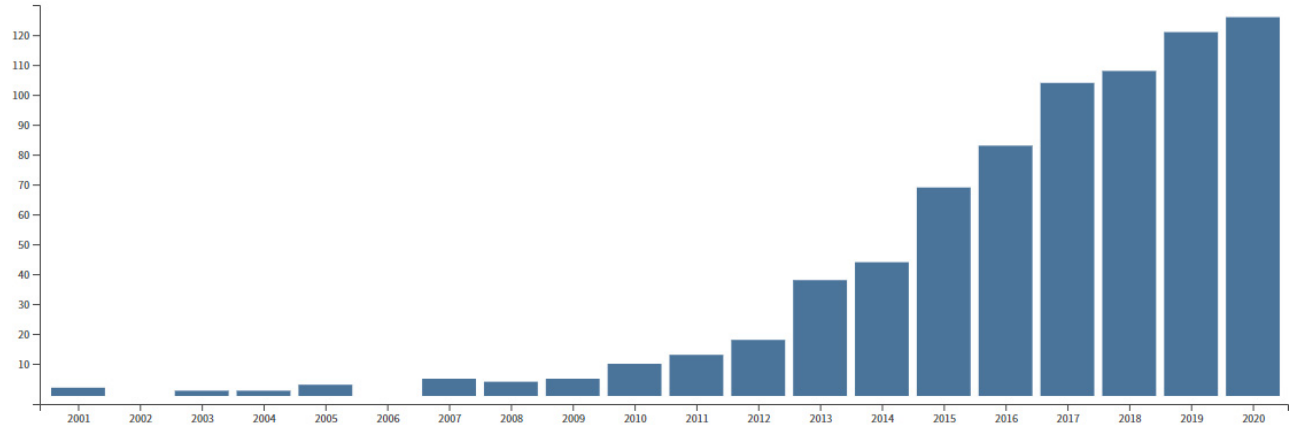
Figure 1. Number of published papers in design optimization of offshore wind turbine (2000–2020).